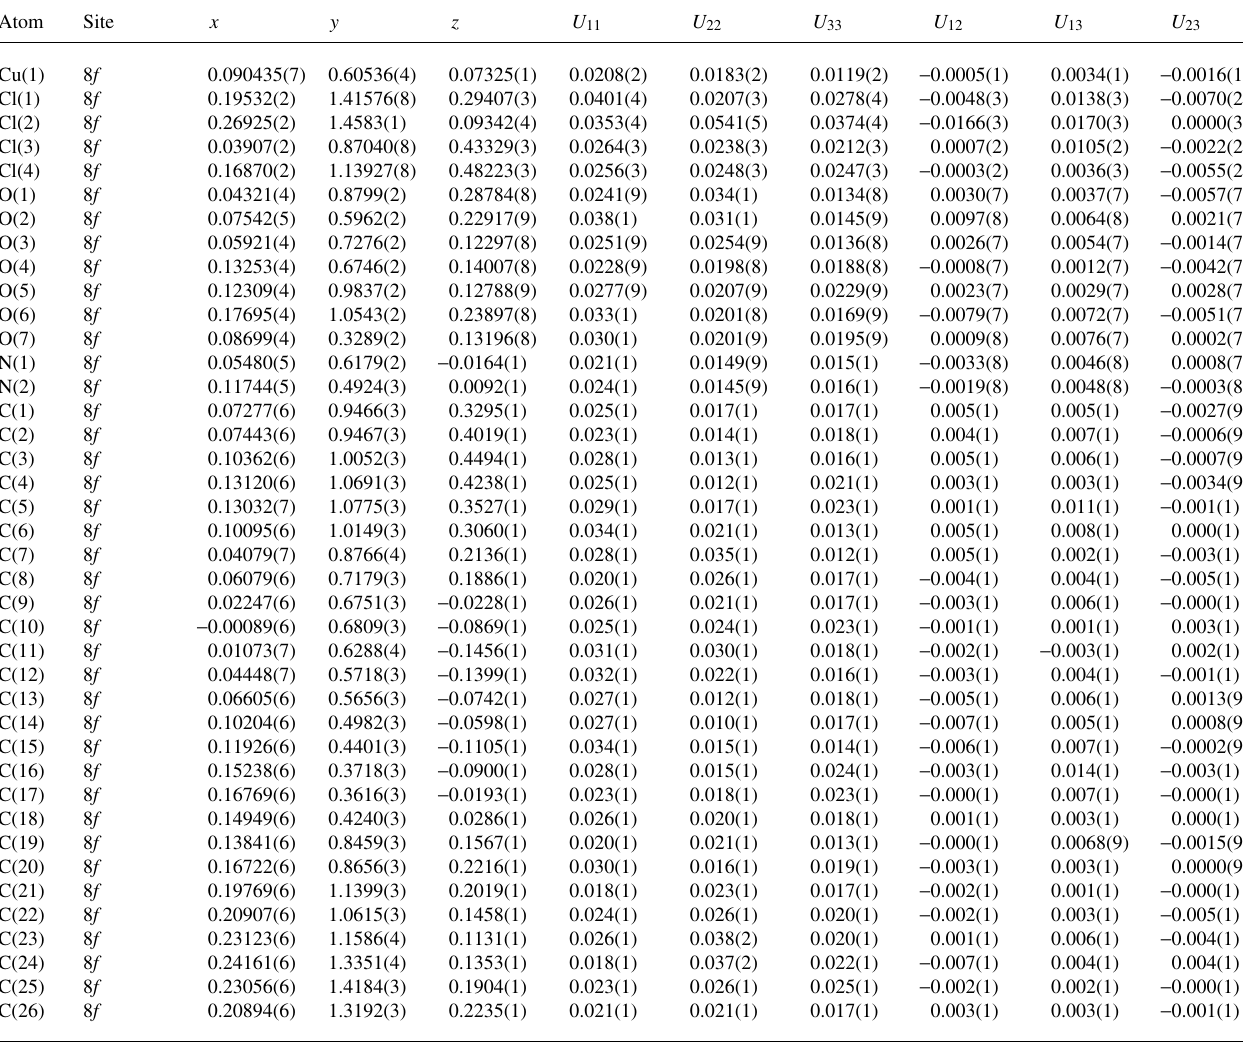
Table 3. Atomic coordinates and displacement parameters (in Å 2 )